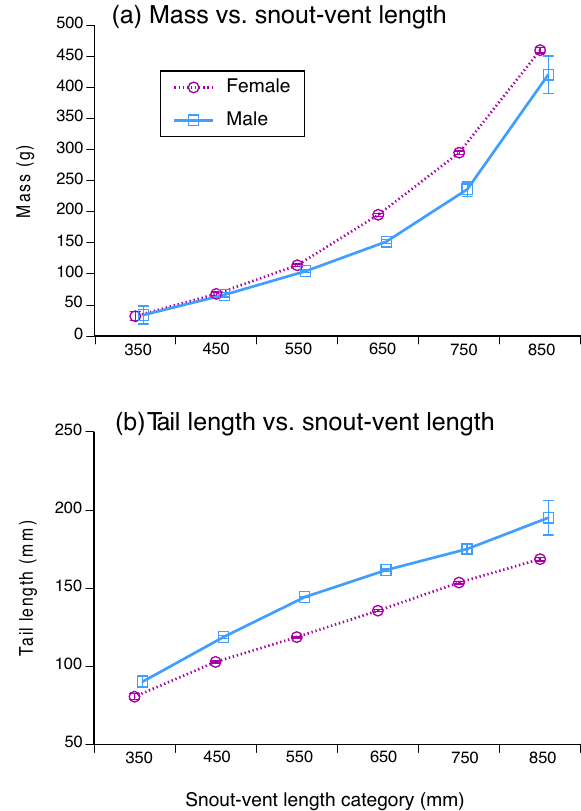
Figure 3. Sexual dimorphism in samples of the Asian bockadam ( Cerberus schneiderii ) examined at processing facilities near the city of Cirebon in West Java. The upper panel ( a ) shows sex-based divergence in body mass relative to snout-vent length (SVL), whereas the lower panel ( b ) shows divergence in tail length relative to snout- vent length. Points show mean values and associated standard errors for each 100-mm interval in snout-vent length, to allow clear visualisation of trends, but statistical tests in the text use continuous data rather than SVL